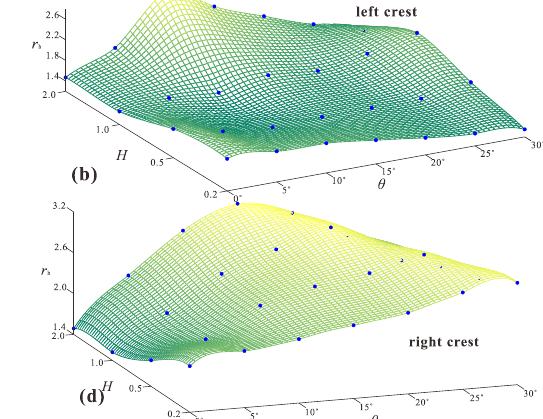
Figure 19. Variations of the horizontal amplification ratios ( r h ) of PGA at the observation points (( a ) left toe, ( b ) left crest, ( c ) right toe and ( d ) right crest) with varied angles of wave incidence at different slope heights.